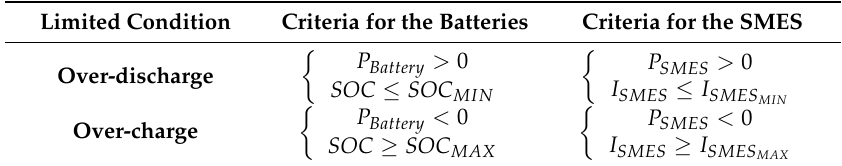
Table 1. Criteria for the “limited condition” of the